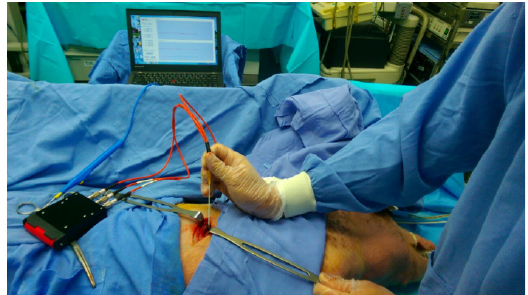
Figure 3. Photograph of the proposed catheter placement assistance system being used during the animal study. The piglet anterior axillary line area was dissected layer by layer from the skin, fat, muscle, subclavian artery, subclavian vein, lung, and pleural cavity.